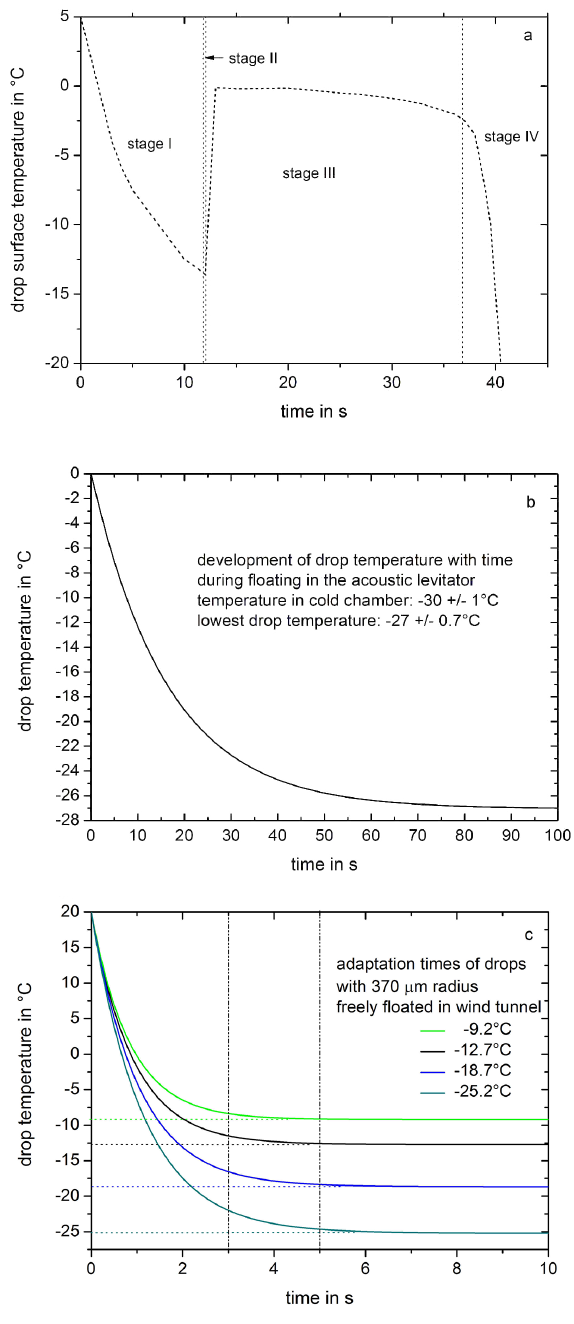
Figure 2. Experimental temperature trajectories. Example of the development of the drop temperature with time during freezing in the acoustic levitator (a) . Development of drop temperature during freely floating in the acoustic levitator at a cold chamber ambient temperature of − 30 ◦ C (b) . Calculated adaptation times of drops with 370µm radius while freely floating in the wind tunnel at vari- ous ambient temperatures (c)